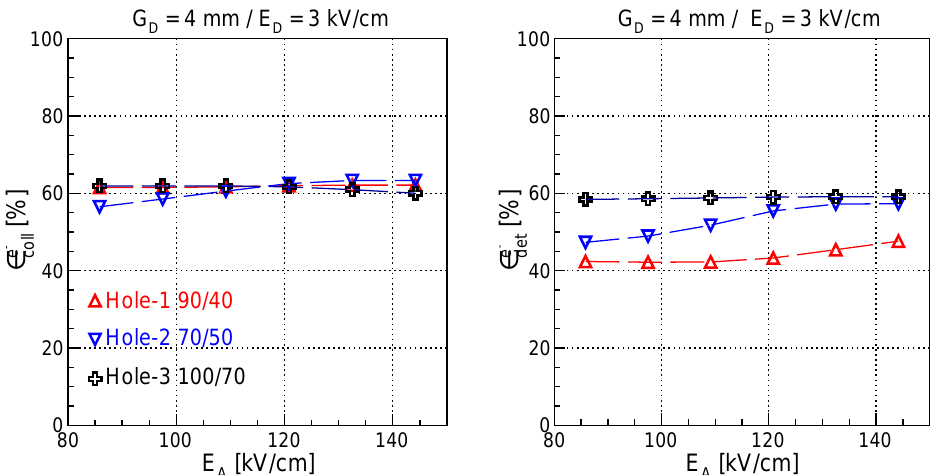
Figure 10. Collection efficiency ( left ) and detection efficiency ( right ) vs. E A .